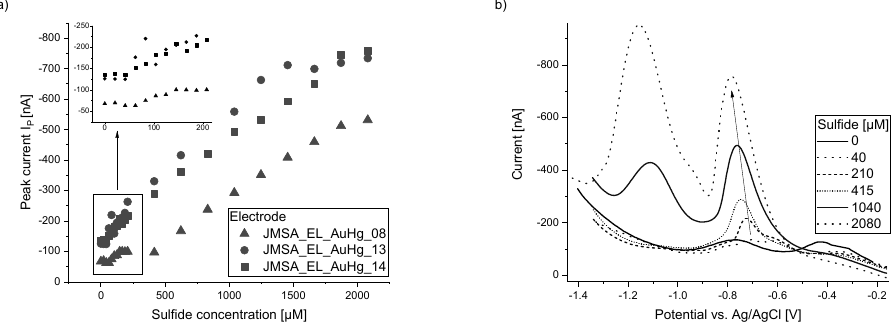
Figure 5. ( a ) Sulfide calibration with three different gold amalgam microelectrodes with the electrode identifiers JMSA_EL_AuHg_08, JMSA_EL_AuHg_13, and JMSA_EL_AuHg_14 (100-µm electrode surface diameter each) and ( b ) selected forward sweeps in sterile AWW 2 at room temperature.